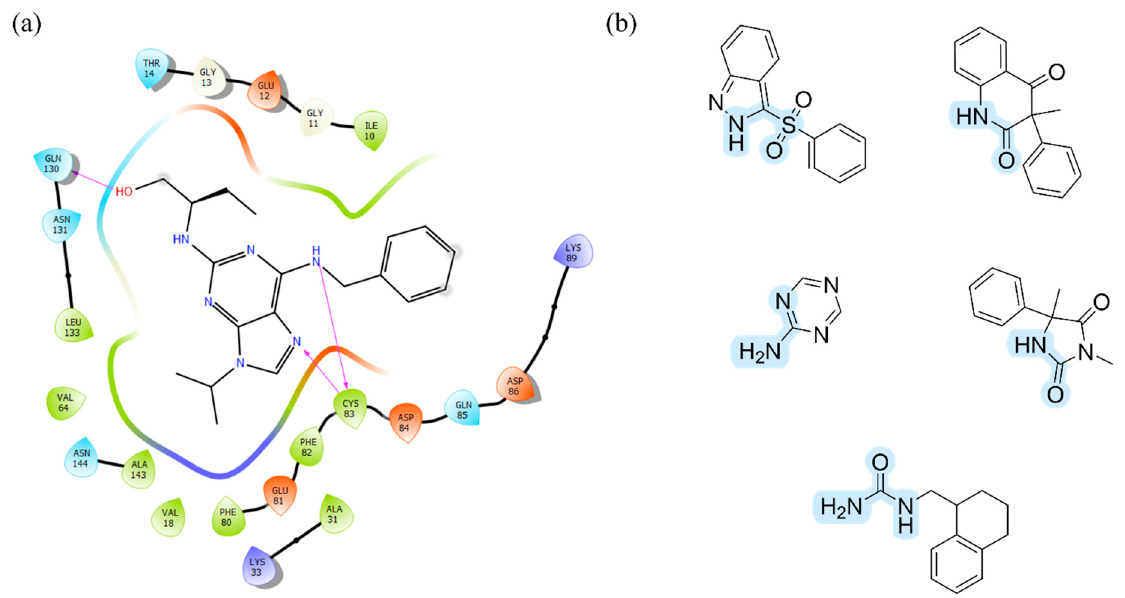
Figure 14. ( a ) 2D protein-ligand interactions for roscovitine—strong CDK5 inhibitor (generated using Schrodinger Suite); ( b ) The examples of structural fragments of 5-HT 6 R ligands favorable for interactions with Cys83 in ATP binding pocket of CDK5.